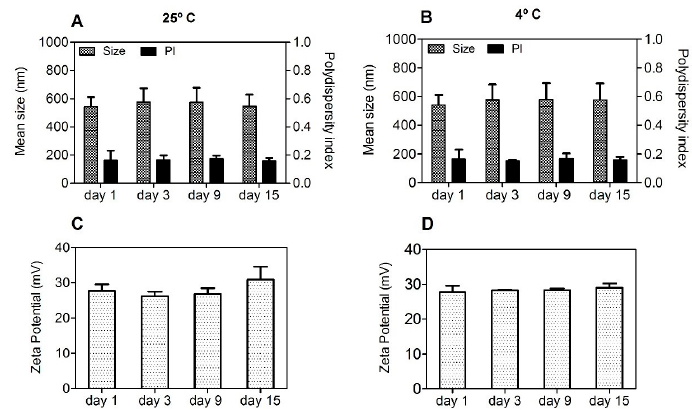
Figure 4. Short-term stability of Chi-C48/80 NPs at 25 °C ( A , C ) and 4 °C ( B , D ). Size, polydispersity index (PI), and zeta potential of the C48/80 loaded formulation were measured during storage up to 15 days at 25 °C or at 4 °C. Data are expressed as mean ± standard deviation (SD), n = 3.